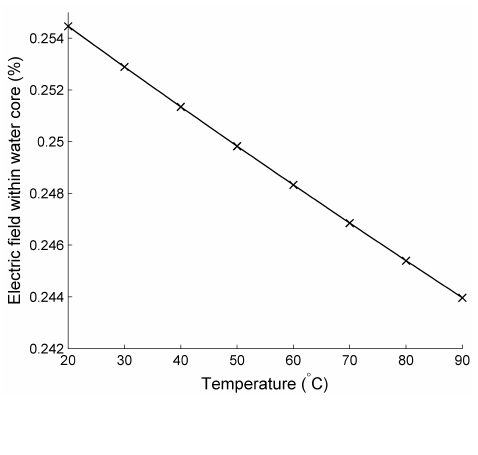
Figure 14. The percentage of the mode overlap within the water channel in relationto